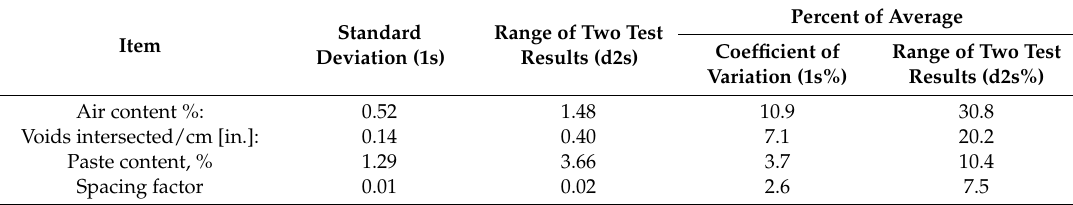
Table 3. Average precision of the assessment made by two operators on a set composed by ten specimens.